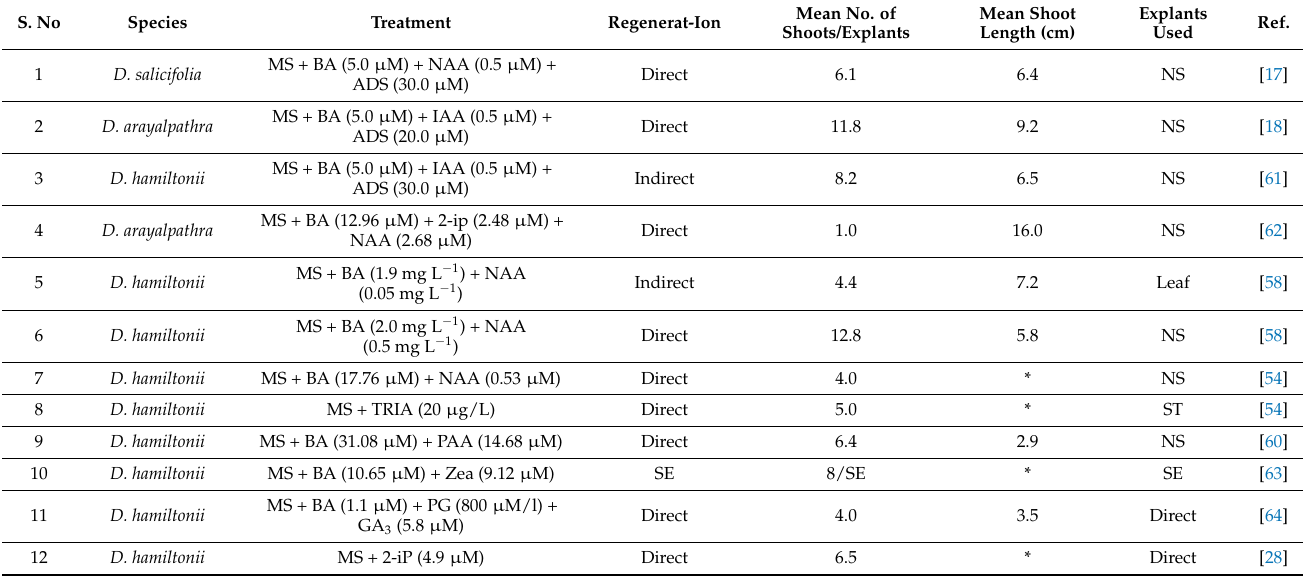
Table 2. In vitro shoot regeneration using different explants in species from the genus Decalepis